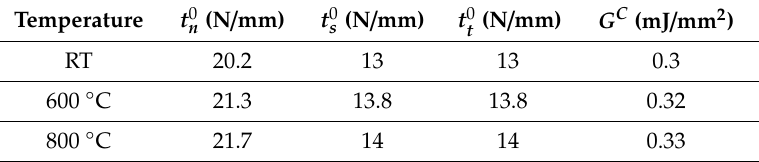
Figure 13. Double linear constitutive relation. Table 2. Cohesion element parameters.